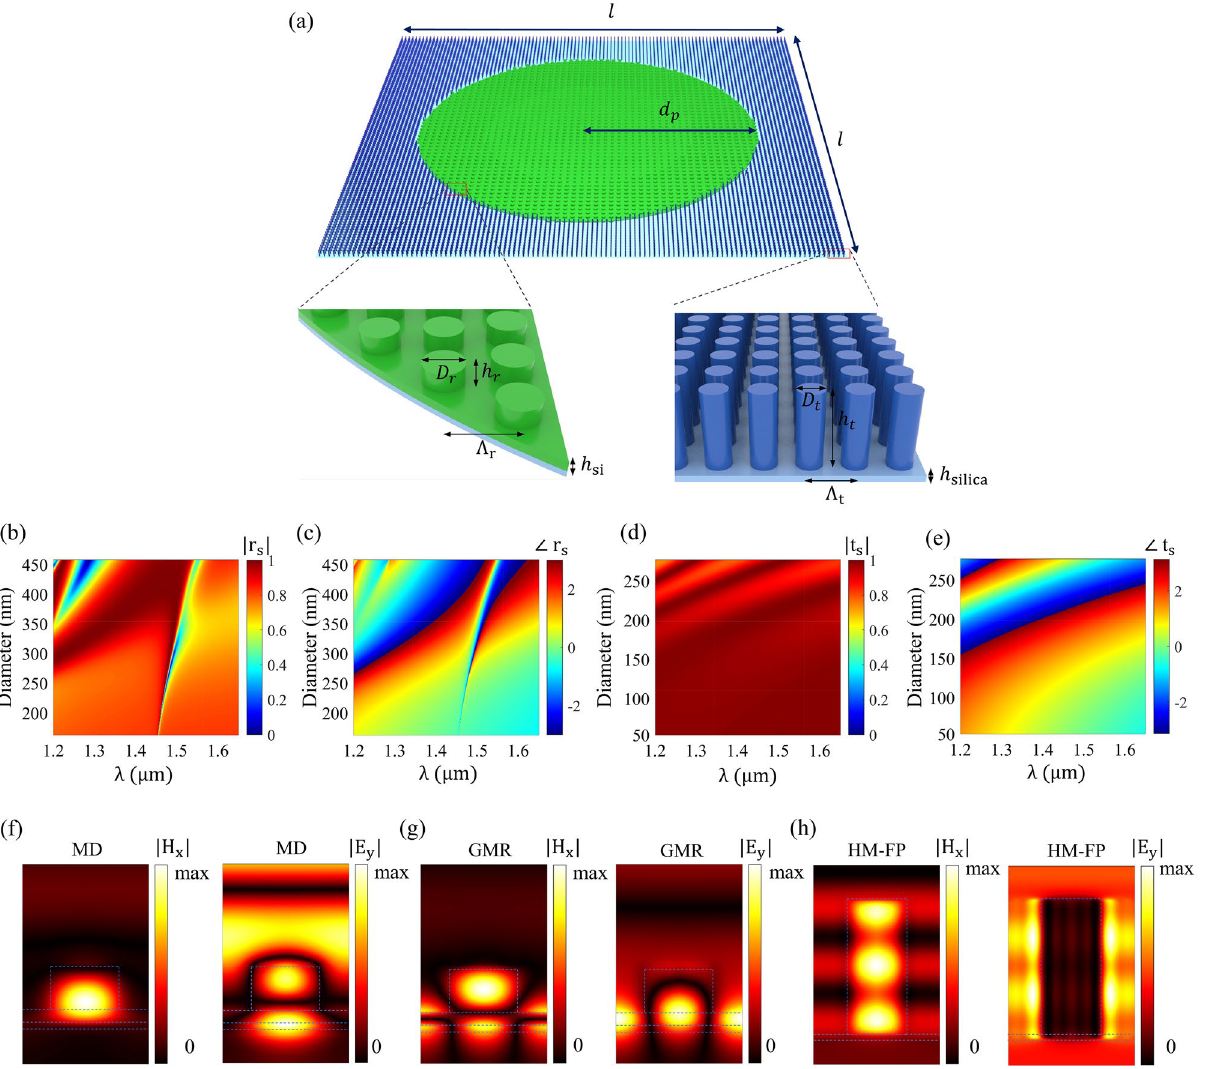
2 m 2 metasurface consisting of broadband reflective and Figure 2. ( a ) The geometry of all-dielectric 2 × transmissive unitcells. The reflective c-Si nanodisks are connected by a thin c-Si layer over a silica substrate while the tall transmissive elements are placed over the silica substrate and the parameter d p determines the 306 nm , (cid:31) 653 nm , reflective portion radius. The dimension of the building blocks are given as: h r r = = 103 nm , h silica 458 nm and h 1349 nm , (cid:31) 323 nm , 60 nm and 163 nm < D h Si r < t = t = = = 277 nm . The reflection amplitude ( b ) and phase ( c ) of the reflective 60 nm and 54 nm < D h silica t < = unitcells under illumination of a s-polarized plane wave. The transmission amplitude ( d ) and phase ( e ) of the transmissive unitcells under illumination of a s-polarized planewave. ( f , g ) The nearfield distribution of the z plane at the resonant wavelengths of MD and GMR for s-polarized magnetic and electric fields in the y − normal incidence, respectively. ( h ) Nearfield distribution of the magnetic and electric fields of transmissive unitcells under normal s-polarized incidence demonstrating the Hybrid Mie–Fabry–Perot (HM-FP) resonance. The schematic and results are Generated by Autodesk 3ds Max and MATLAB,